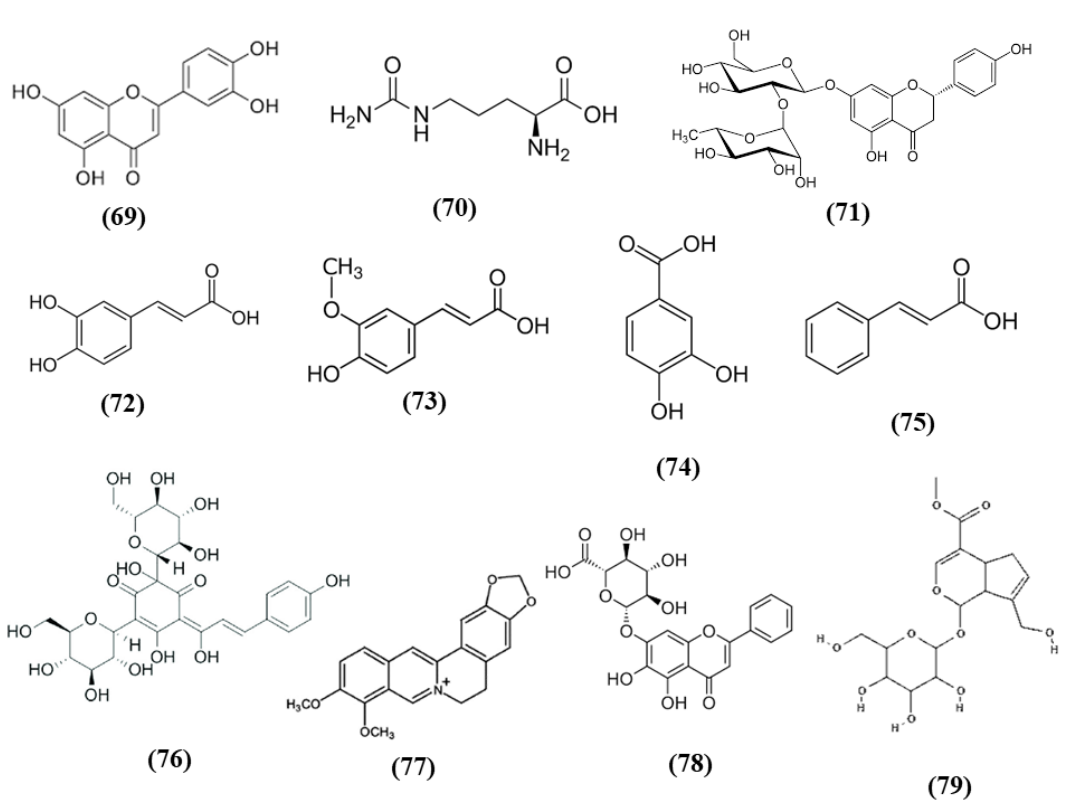
Figure 13. Chemical structure of ( 69 ) luteolin, ( 70 ) citrulline, ( 71 ) naringin, ( 72 ) caffeic acid, ( 73 ) ferulic acid, ( 74 ) protocatechuic acid, ( 75 ) cinnamic acid, ( 76 ) hydroxysafflor yellow A, ( 77 ) berberine, ( 78 ) baicalin, and ( 79 ) jasminoidin.